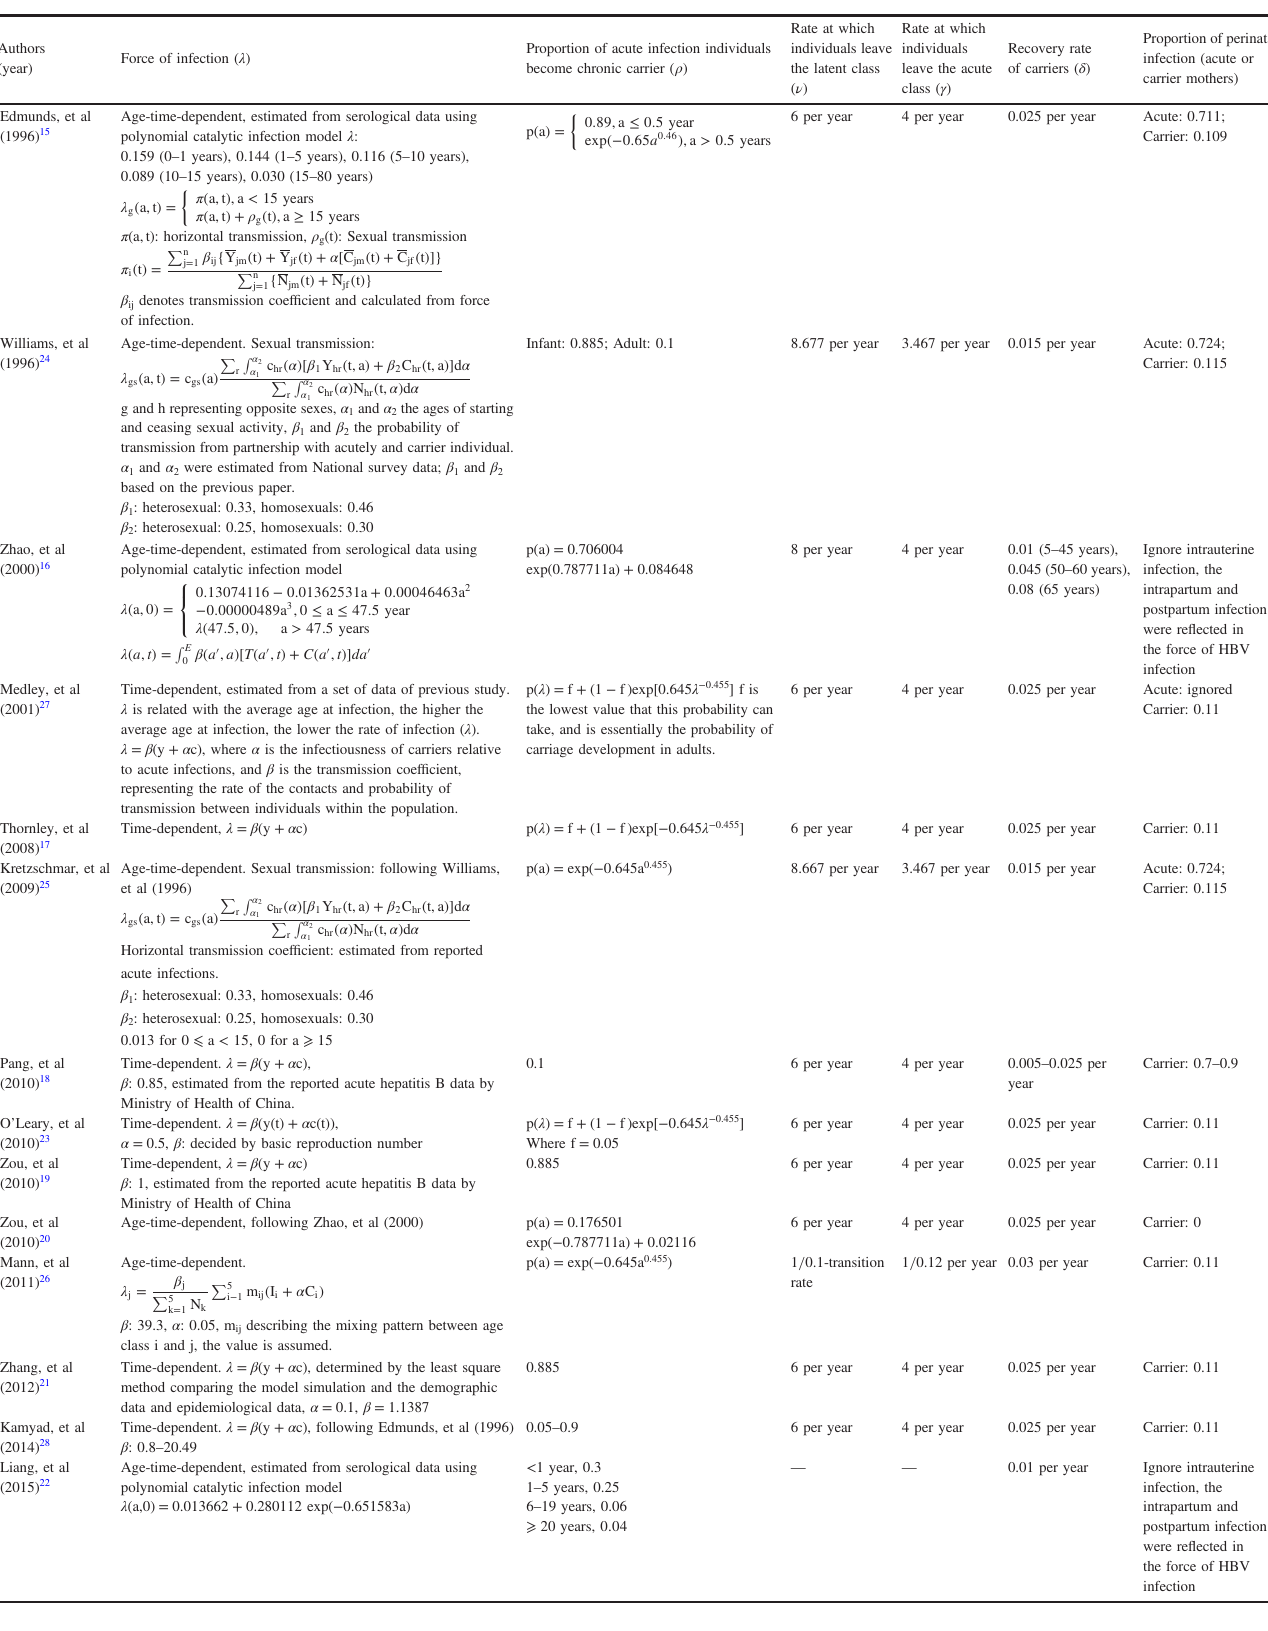
become chronic carrier ( ρ )